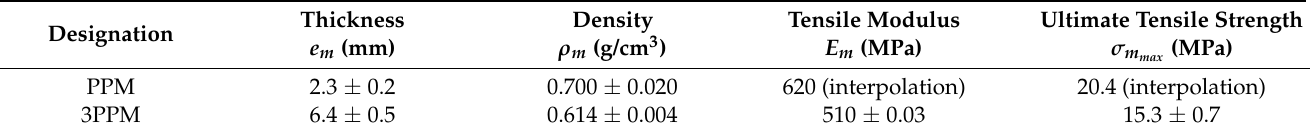
Table 5. Experimental and interpolated properties of the m -layer foam for different